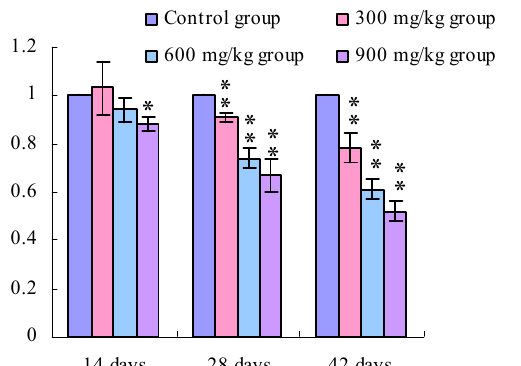
Figure 2. The TLR2-2 mRNA expression levels in the jejunal mucosa in broiler.